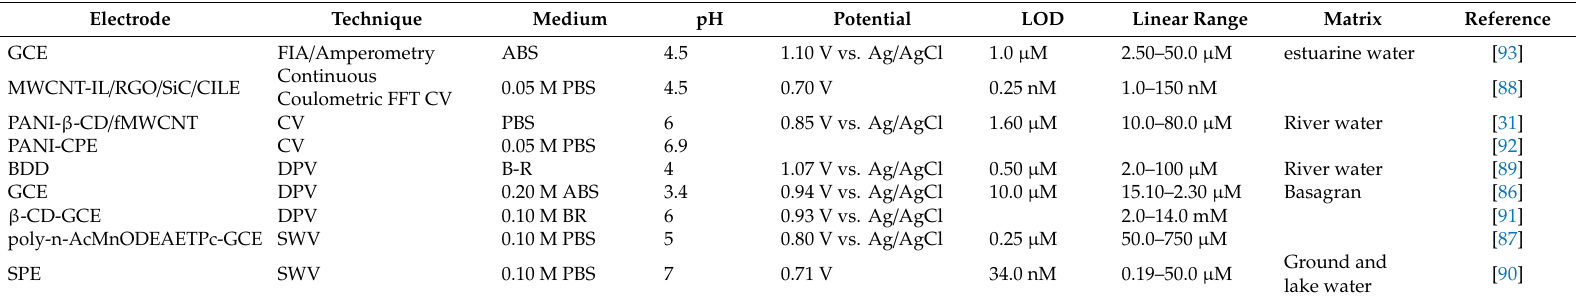
Table 3. An overview of di ff erent electroanalytical techniques, measurement conditions, analytical performance and electrode material used for the determination of